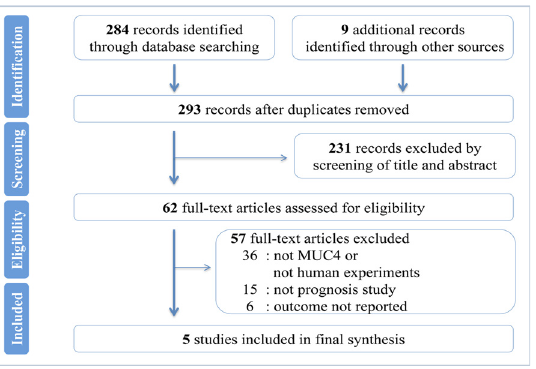
Fig 1. Flowchart of the study selection. Systematic search and selection of relevant